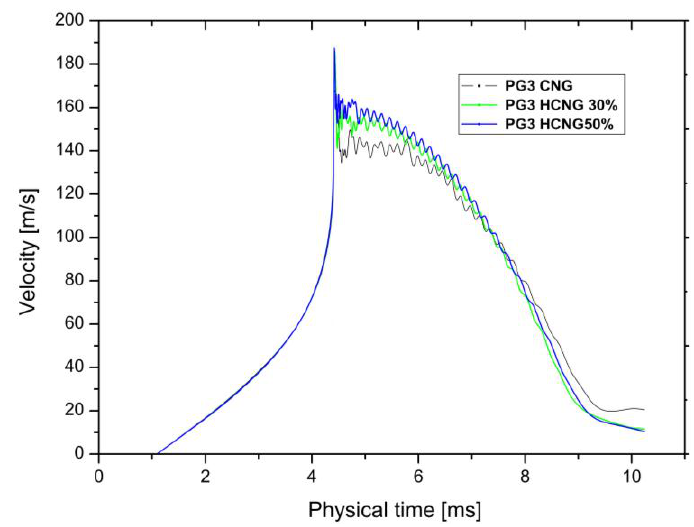
Figure 10. Unsteady in-cylinder flow in the PG3 location.